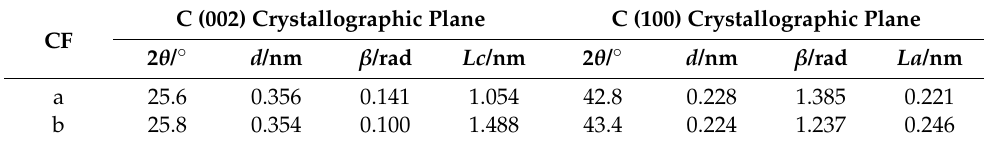
Table 4. XRD Patterns of Untreated and Treated Carbon Felts (a: Untreated; b: Treated Carbon Felts). C (002) Crystallographic CF